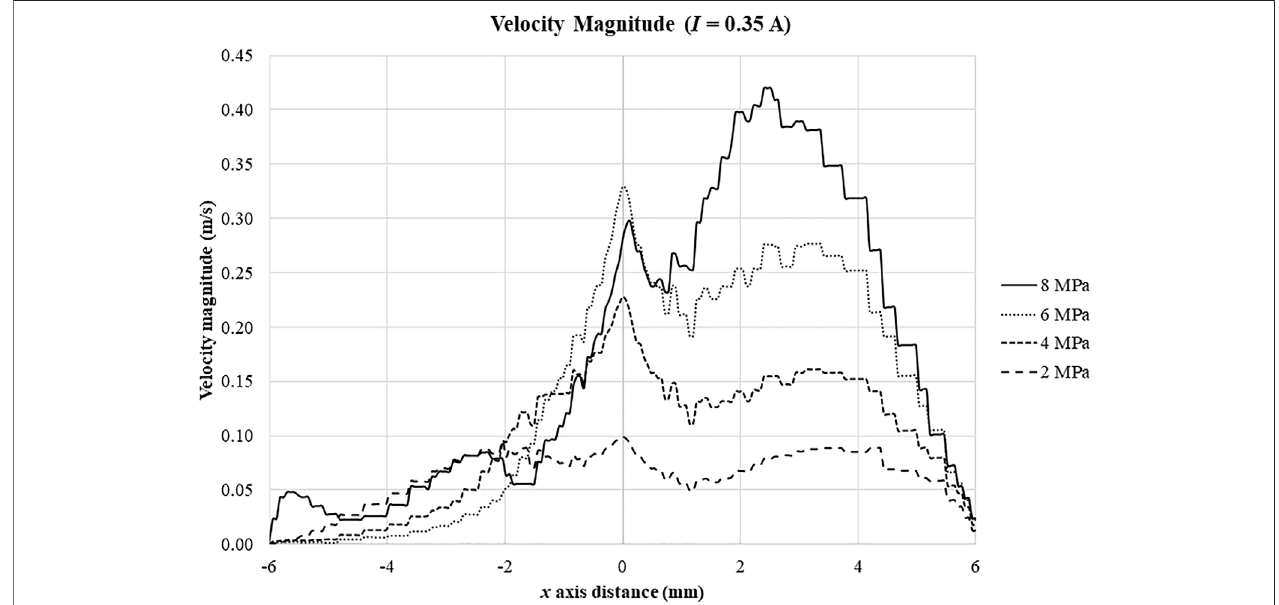
FIGURE 5 | Velocity magnitude in the x axis direction at the center of the inter-electrode gap ( t (cid:2) 50 ms, I (cid:2) 0.35 A).